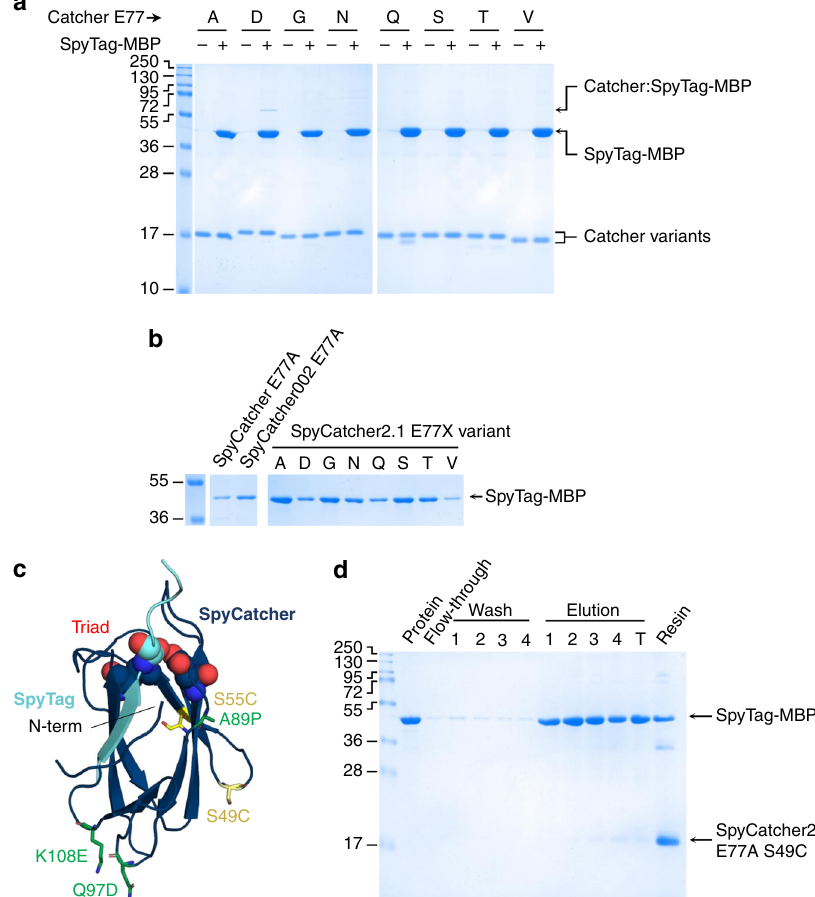
Fig. 2 Design of SpyDock. a All small residues except D blocked SpyCatcher reaction. E77 was mutated to the indicated residue and incubated with SpyTag-MBP for 24 h, before boiling in SDS and analysis by SDS-PAGE with Coomassie staining. b Additional mutations in SpyCatcher enhanced Spy&Go puri fi cation. The original SpyCatcher, the evolved SpyCatcher002 or SpyCatcher2.1 bearing the E77A mutation were compared for capture and elution of SpyTag-MBP (SDS-PAGE with Coomassie staining). Further E77X mutations were similarly explored on SpyCatcher2.1. c Positions of mutations screened for SpyDock acceleration, based on Protein Data Bank 4MLI; CnaB2 triad represented in spheres, anchoring sites in yellow, and SpyCatcher2.1 accelerating mutations in green. d S49C resin anchoring allowed ef fi cient SpyDock puri fi cation. SpyCatcher2.1 E77A S49C was coupled to SulfoLink resin and tested for SpyTag-MBP capture and release (SDS-PAGE with Coomassie